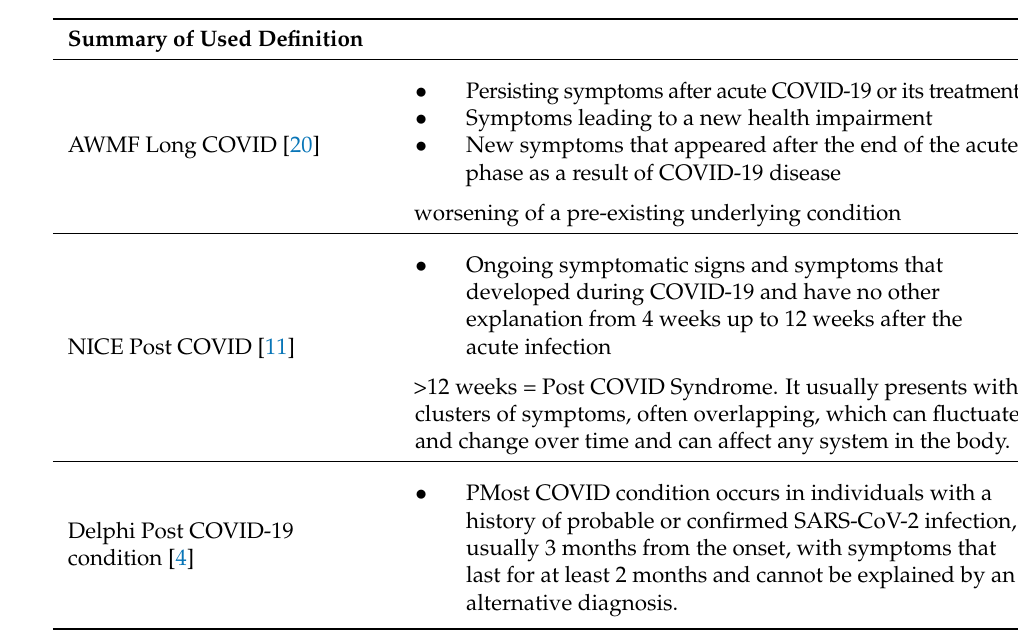
Table A1. Used Definitions for